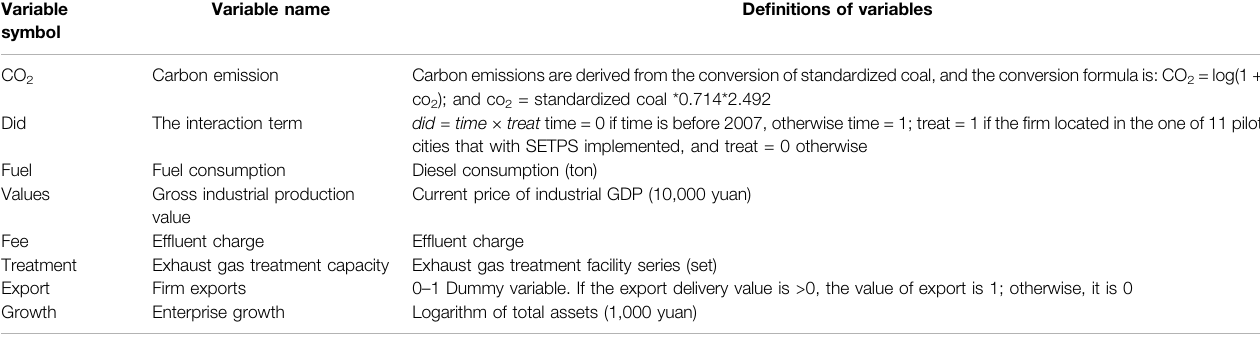
TABLE 1 | Variable de fi